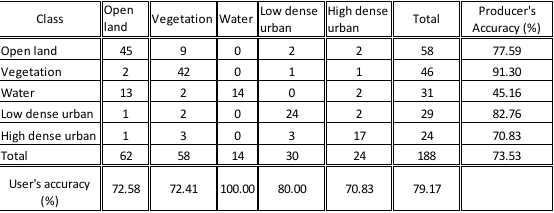
Table 1. Confusion matrix of classified map generated